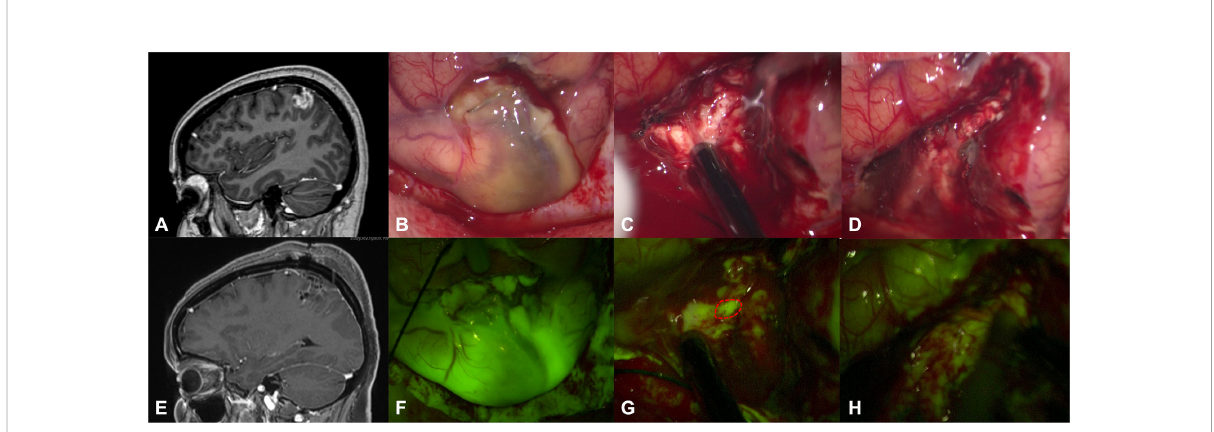
FIGURE 1 Preoperative T1 with contrast sagittal scan (A) in a 54-year-old female (patient n.8) shows a left frontal anaplastic pleomorphic xanthoastrocytoma with a gross-total resection, as detectable by postoperative post-contrast T1 MRI in (E) . After dural opening, it was possible to appreciate a greyish and pale lesion (B) that was better highlighted after activation of YELLOW 560 fi lter (F) . The tumor was removed with an inside-out fashion with the aid of a monopolar suction probe, showing a bleeding, friable tissue (C) . During surgical resection, fl uorescein helps the surgeon to identify residual pathological tissue (dotted lines in G ), not clearly visible under white light (C) . At the end of resection (D, H) , no more fl uorescent/pathological areas were detectable with the YELLOW 560 fi lter activated or with white light